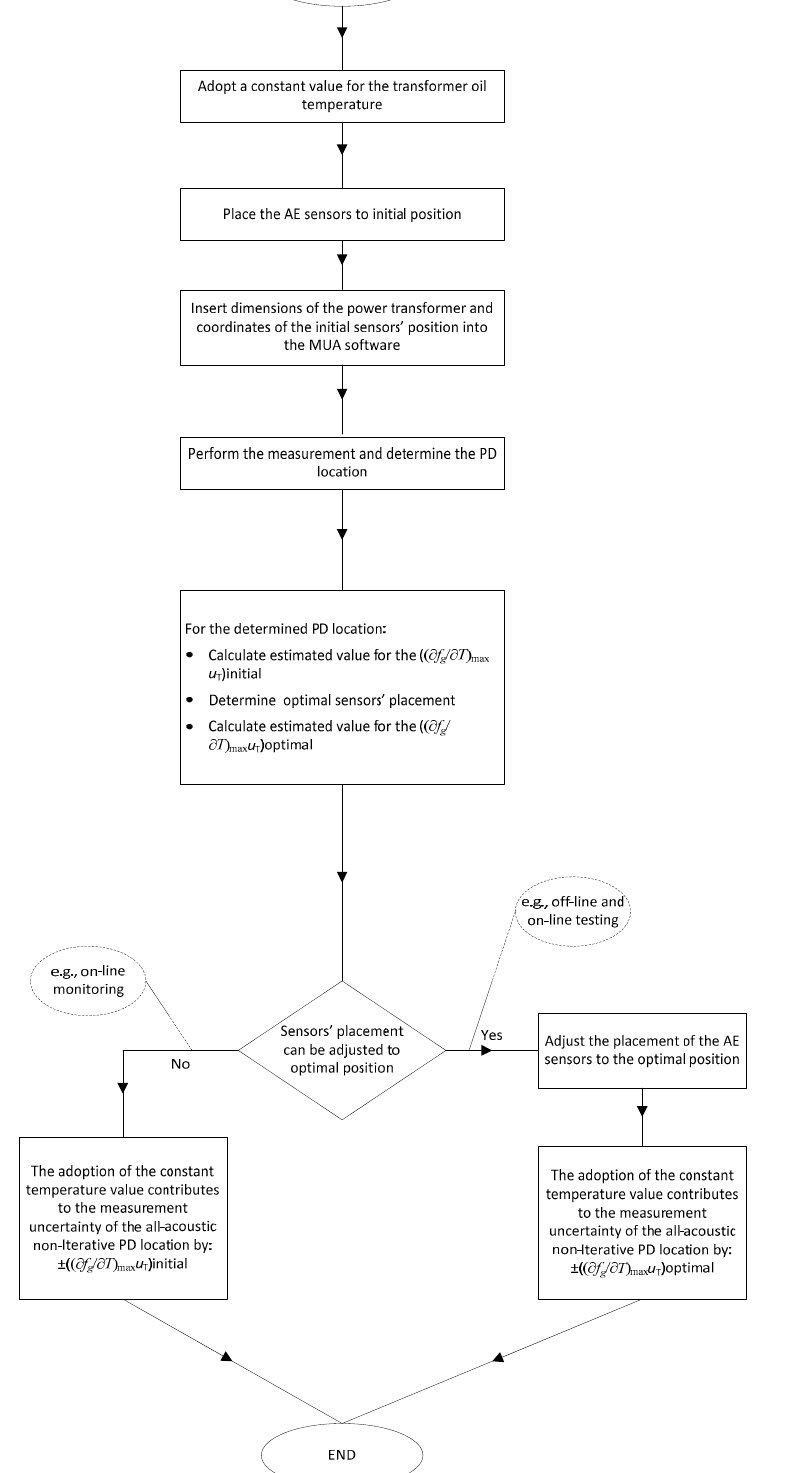
Figure 14. The proposed procedure for quantifying and controlling the contribution of oil temperature to the combined measurement uncertainty of the non-iterative algorithm using the MUA software. The result of the procedure is the quantified contribution of oil temperature to the measurement uncertainty of the method due to the assumption of the constant temperature value. It is assumed that PD is located in the transformer oil.